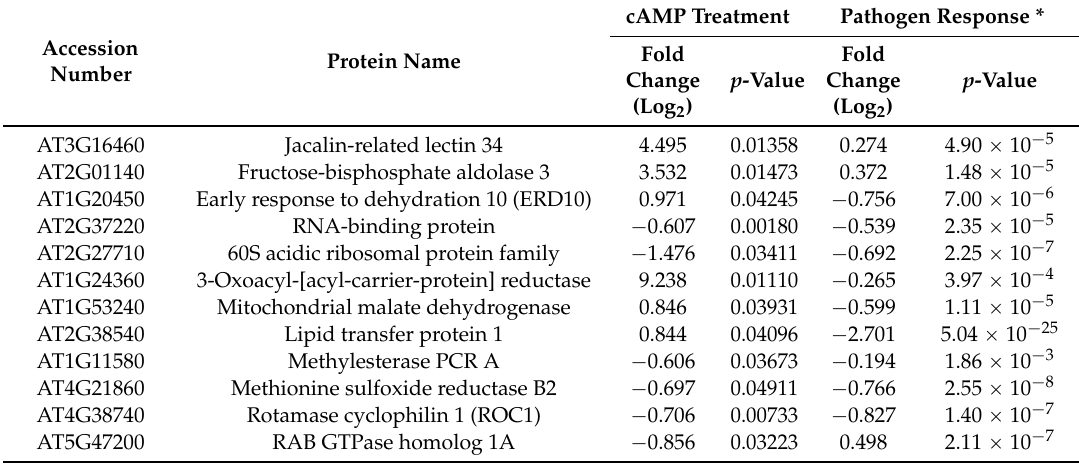
Table 2. Comparison between proteins responsive to cAMP and proteins involved in pathogen